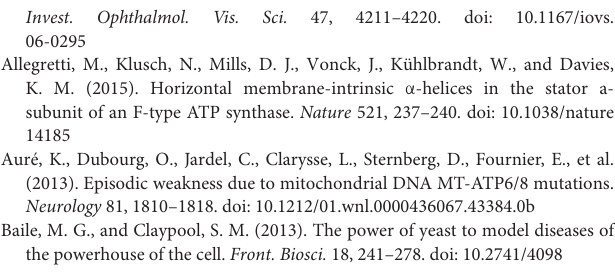
half of subunit a (Hahn et al., 2016). Four of the